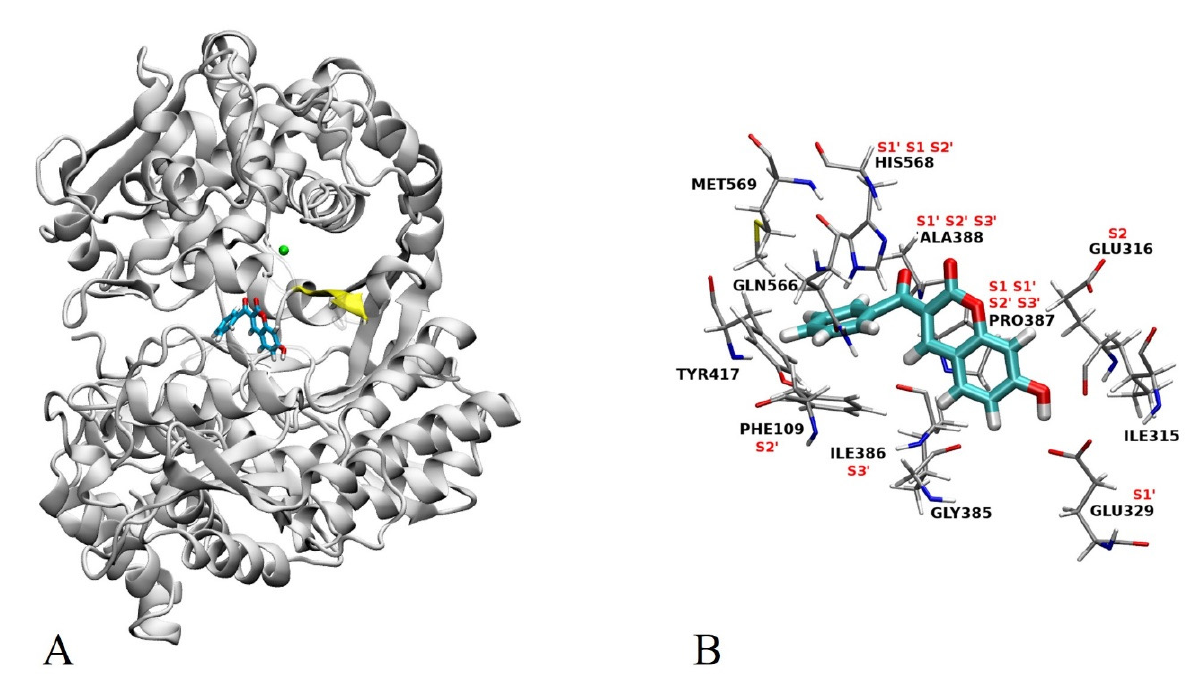
Figure 4. ( A ) Best docking pose for compound 12 in the inter-domain cleft of hDPP III. Compound 12 is shown in stick representation, the lower β sheet is colored yellow, and zinc cation is represented as a green sphere. ( B ) Potential interactions of compound 12 with amino acid residues of hDPP III as presented in the 2D scheme (Figure S1). Substrate binding subsites S1, S1 ′ , S2, S2 ′ and S3 ′ are indicated.